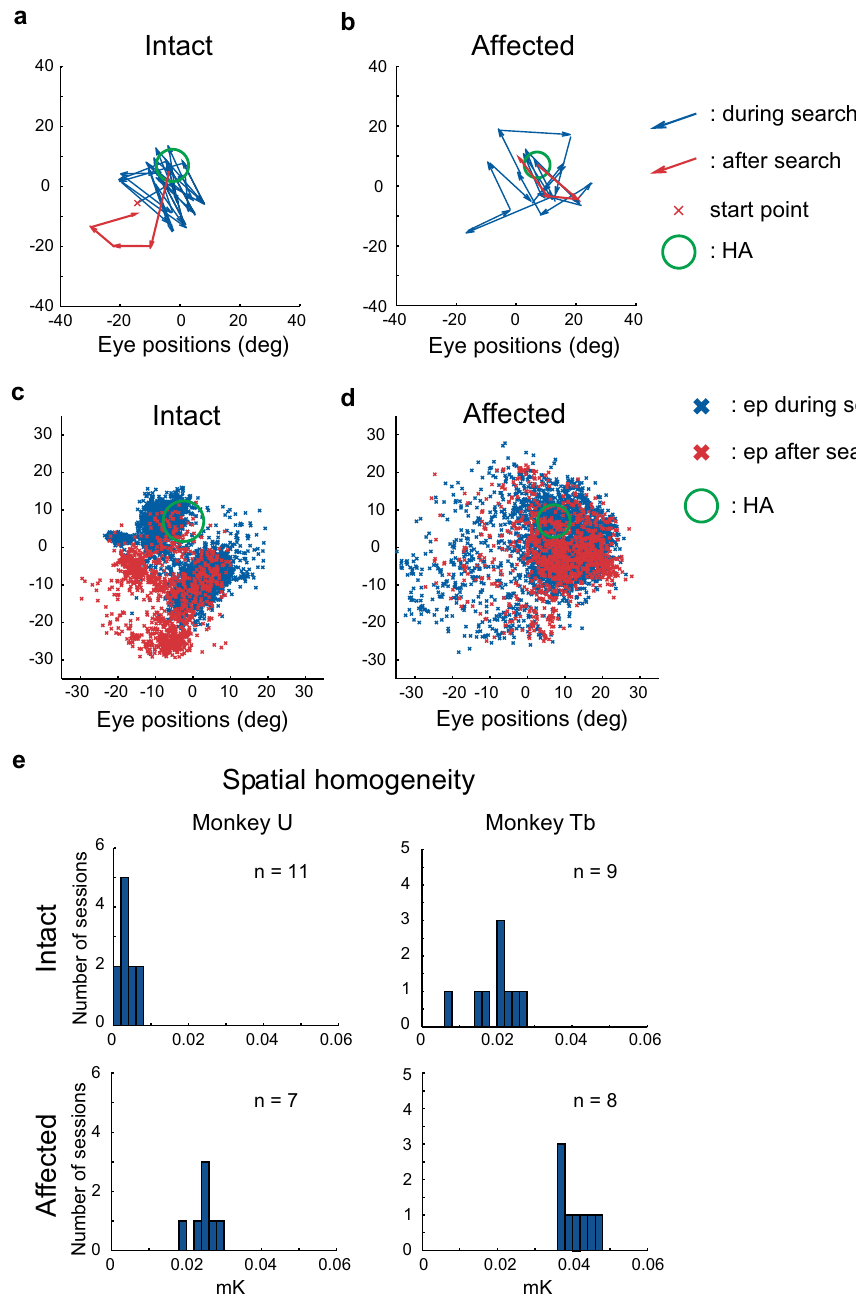
Figure 6. Patterns of eye movements differed after CS presentation to the intact and lesion-affect visual fields. ( a )–( d ) During a single search trial, saccades before (blue lines) and after (red lines) CS presentation to the intact ( a ) and lesion-affected ( b ) visual fields. In a whole session, the distributions of saccade end points (ep) before (blue) and after (red) CS presentation to the intact ( c ) and lesion-affect ( d ) visual fields. ( e ) Spatial homogeneity of distributions of saccade end points in each session calculated by modified Rippley’s K function between before and after CS presentation to the intact and lesion-affected visual fields